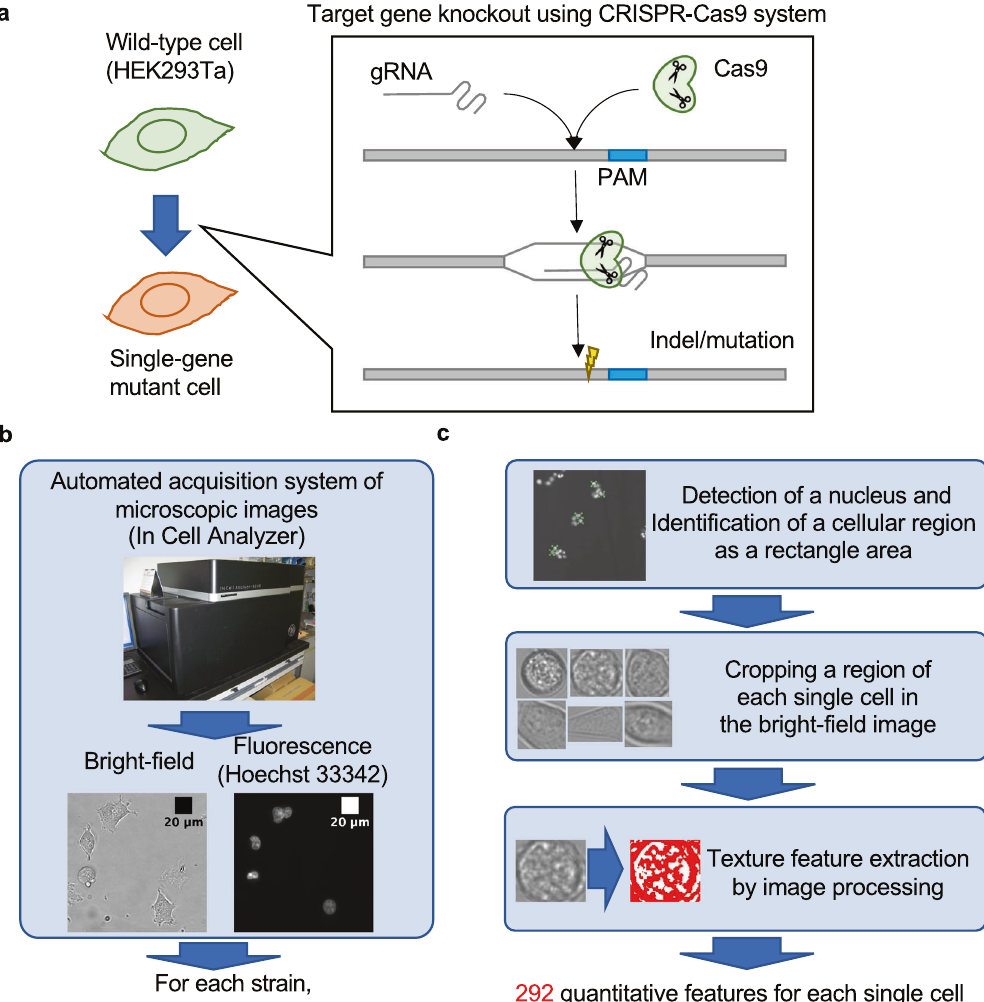
Fig. 1 Work fl ow for the image analysis of single-gene mutant cells. a HEK293Ta was used as parental cells (wild type), and single-gene knockout mutant cells were produced by CRISPR-Cas9 genome editing. b Cell imaging. Using an automated image acquisition system, the BF image and the fl uorescent image (Hoechst33342) of over 670 cells were obtained for each mutant and the wild type. c Quanti fi cation of texture features for each single cell. Each single-cell region was identi fi ed based on the position of a nucleus, and texture features were quanti fi ed from the BF